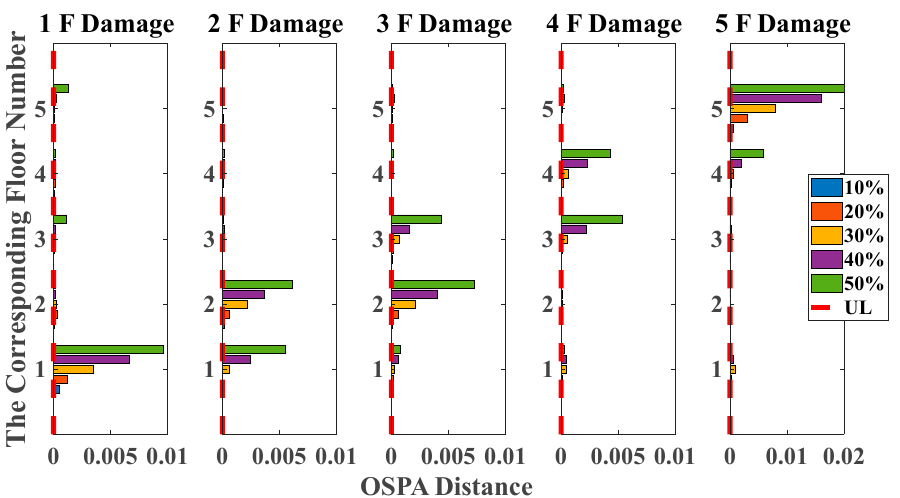
Figure 9. Damage detection results based on the OSPA distance (El Centro earthquake excitation, 5% noise, autoregressive model, data length = 4000, AR order = 1, OSPA.p = 2).